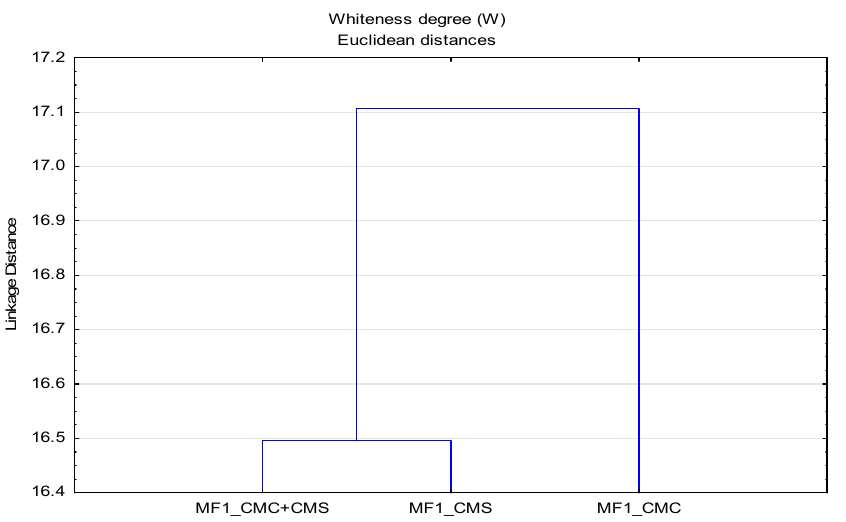
Figure 13. Dendrogram of the whiteness degree (W) of MF as a function of polymers surface modi- fiers.